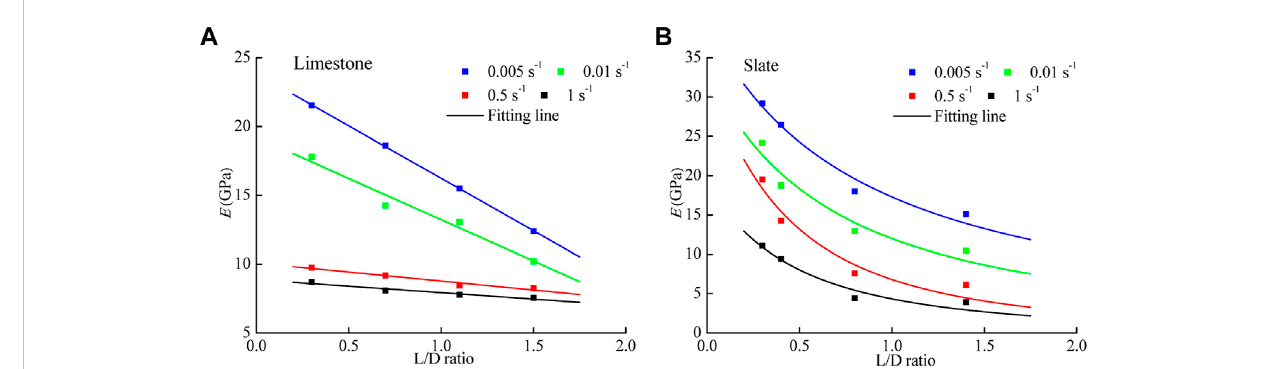
FIGURE 6 Relationship between the elastic modulus and the L/D ratio under different strain rates. (A) Limestone and (B) Slate.